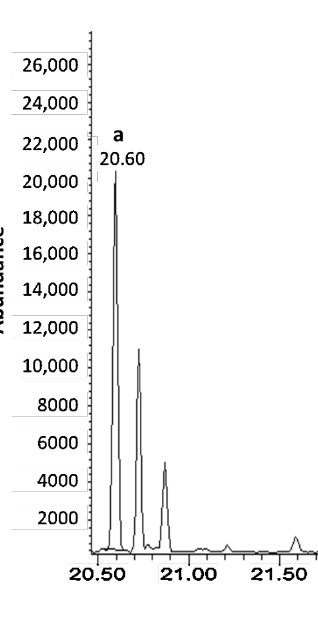
Figure 5. GC-MS chromatograms of the standard phytosterol at 50 ppm. The numbers on the peaks Figure 5 correspond to (a) cholestane as internal standard, (b) campesterol, (c) stigmasterol, (d) b-sitosterol, and (e)